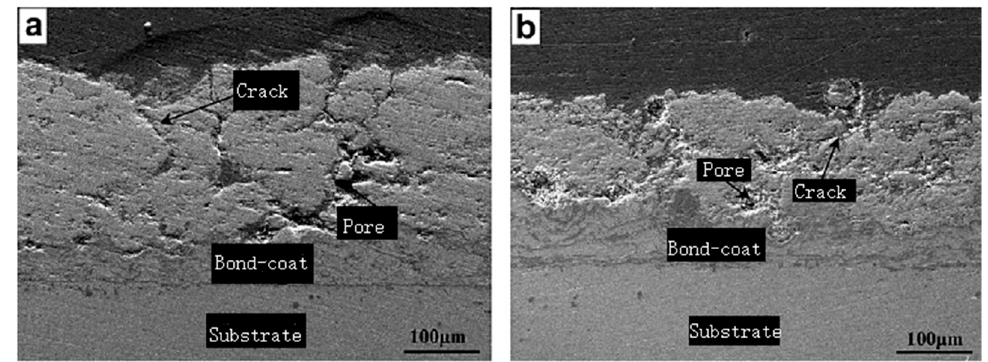
Figure 9. Cross-sectional image: ( a ) conventional 8YSZ thermal barrier coating (TBC); ( b ) nanostructure 8YSZ TBC [61]. Reprinted with permission from [61]; 2011 Elsevier.